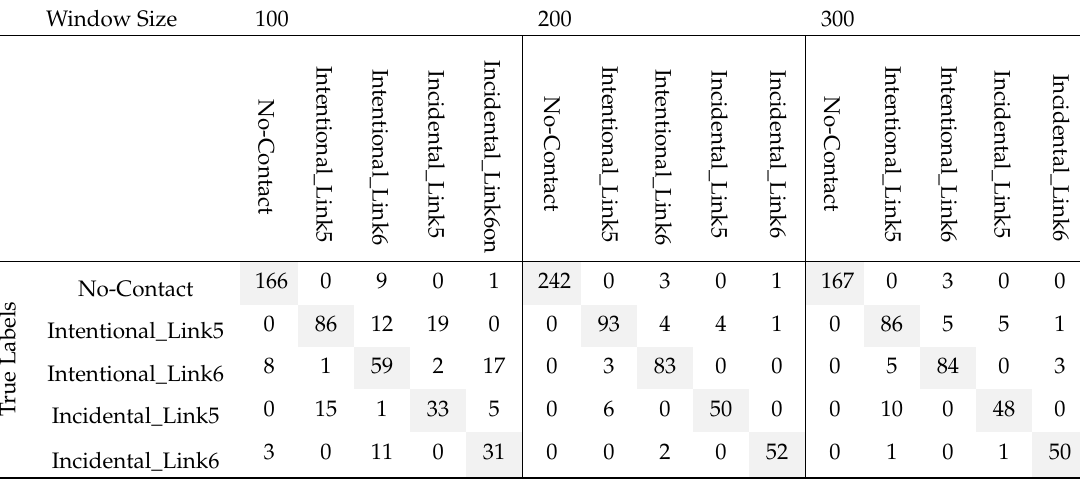
Table 4. Confusion matrix of trained networks for contact detection with di ff erent window size. Window